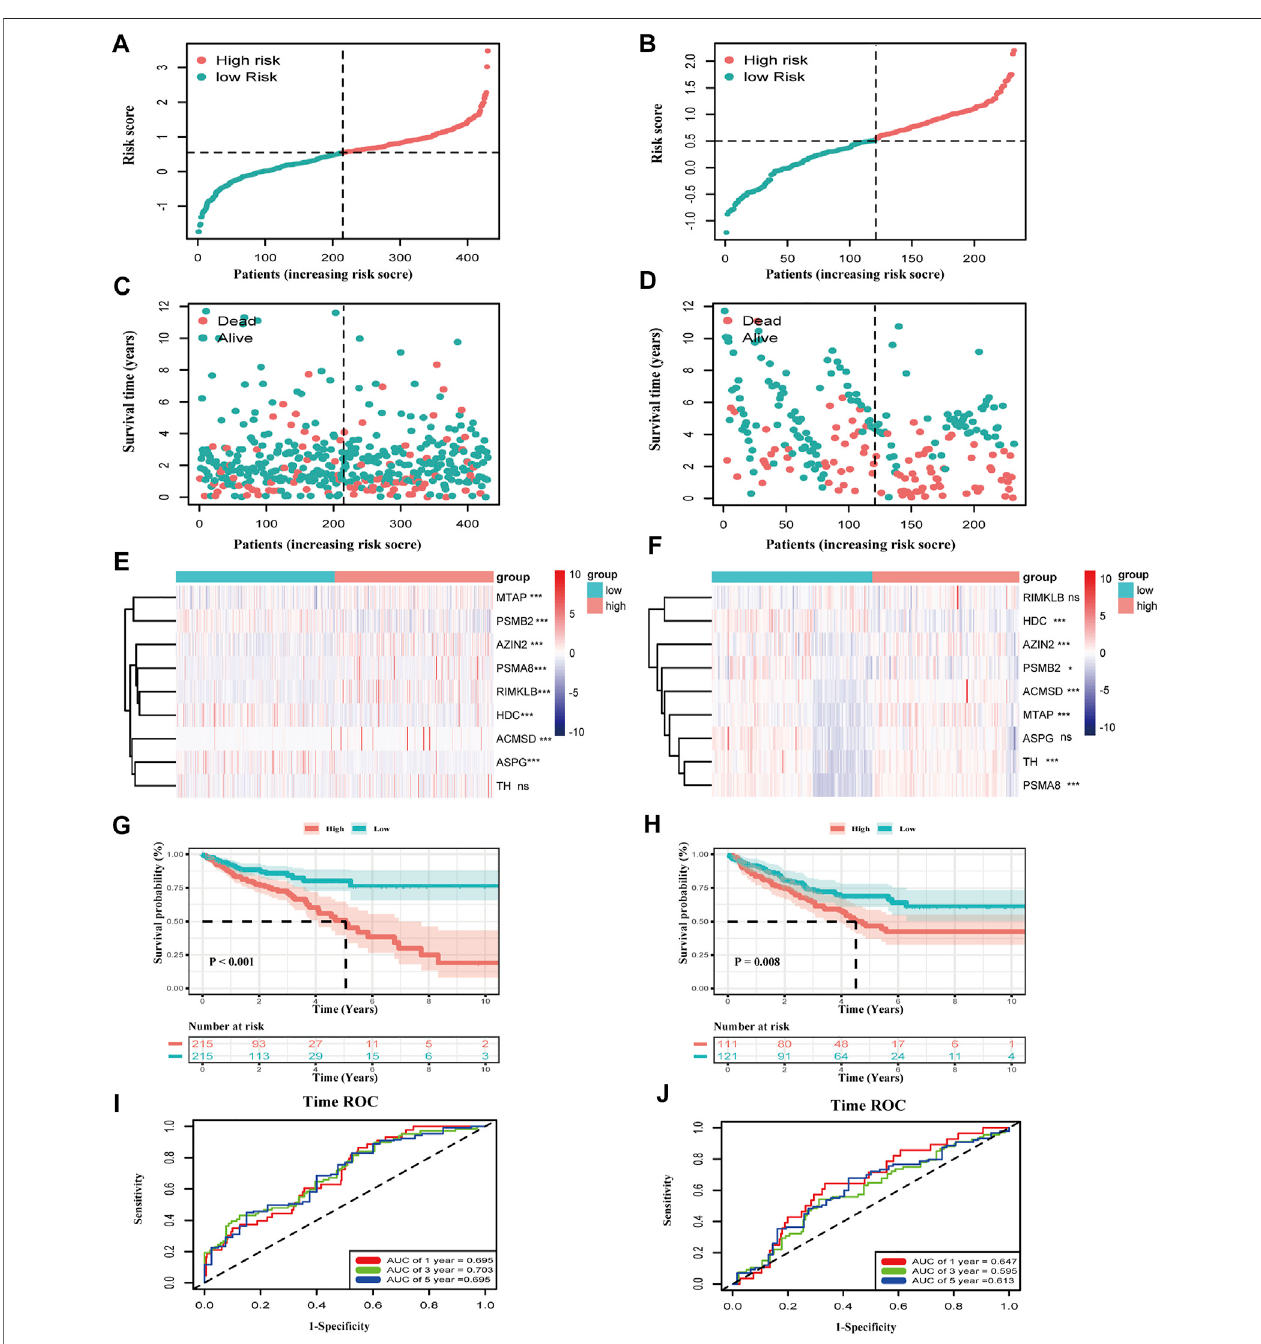
FIGURE 3 | Validation of the risk model in TCGA-COAD and GSE17538. (A,B) The distribution of risk score in COAD patients. (C,D) Distribution of survival time in COAD patients. (E,F) Expression of the nine genes between the two groups in two datasets (*** p < 0.001, ** p < 0.01, * p < 0.05, ns: p ≥ 0.05). (G,H) K – M curves of the two groups in twodatasets (TCGA-COAD: p < 0.001, GSE17539: p = 0.008). (I,J) Time ROCof 1,3, and 5 survival years ofCOAD patients inthe training and validation sets. The area under the curve is the AUC value (AUC of TCGA-COAD: 1 year = 0.695, 3 years = 0.703, and 5 years = 0.695; AUC of GSE17538: 1 year = 0.647, 3 years = 0.595, and 5 years =